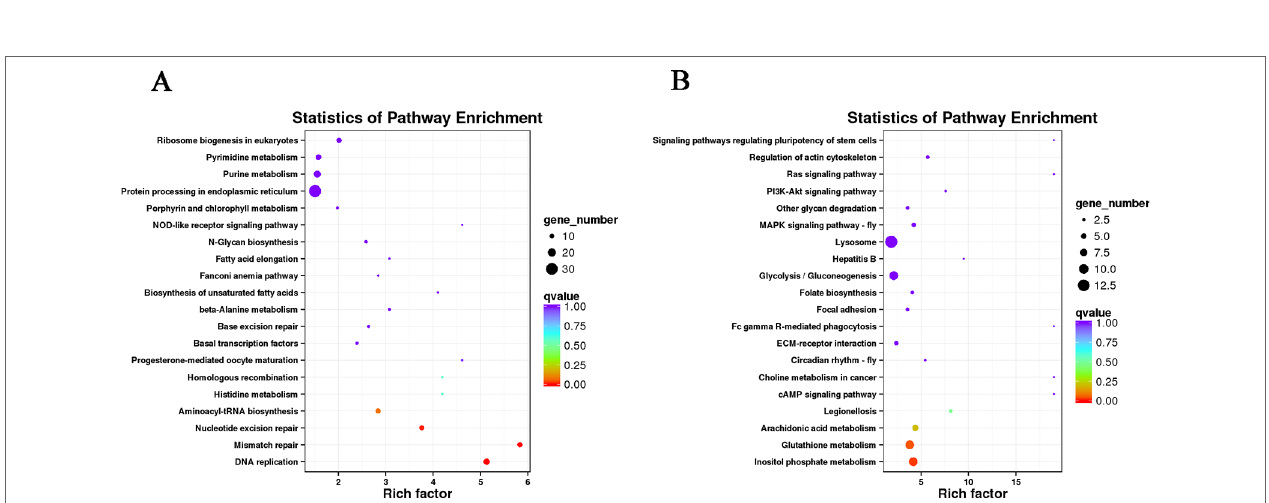
FIGURE 3 | Pathway enrichment of differentially expressed transcripts in muscle (A) and gonad (B) . Each circle represents a Kyoto Encyclopedia of Genes and Genomes pathway. The vertical axis displays the pathway name and the horizontal axis represents the enrichment factor, which indicating the ratio of the proportion of transcripts annotated into a certain pathway in differentially expressed transcripts (DETs) to the proportion of transcripts annotated into that pathway in all transcripts. A higher enrichment factor represents a more significant enrichment level of DETs in this pathway. The color of the circle represents q-value, which is the P value after correction of multiple hypothesis test. The smaller q-value indicates more reliable enrichment of DET in this pathway. The size of the circle indicates the number of transcripts enriched in the